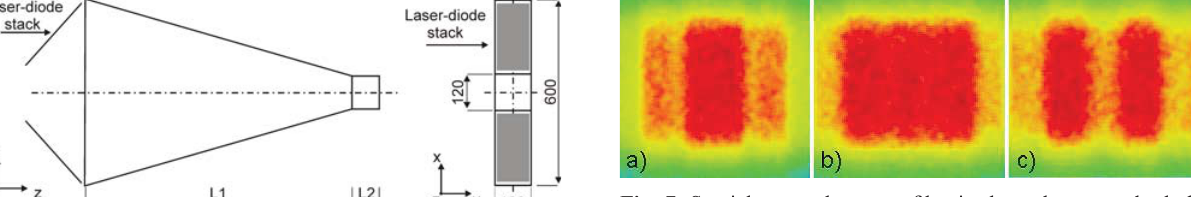
Fig. 7. Spatial output-beam profiles in dependence on the hol- low duct L 2 length – a) L 2 = 120 mm, b) L 2 = 165 mm and c) L 2 = 200 mm – in the proximity of the waveguide-structure output-